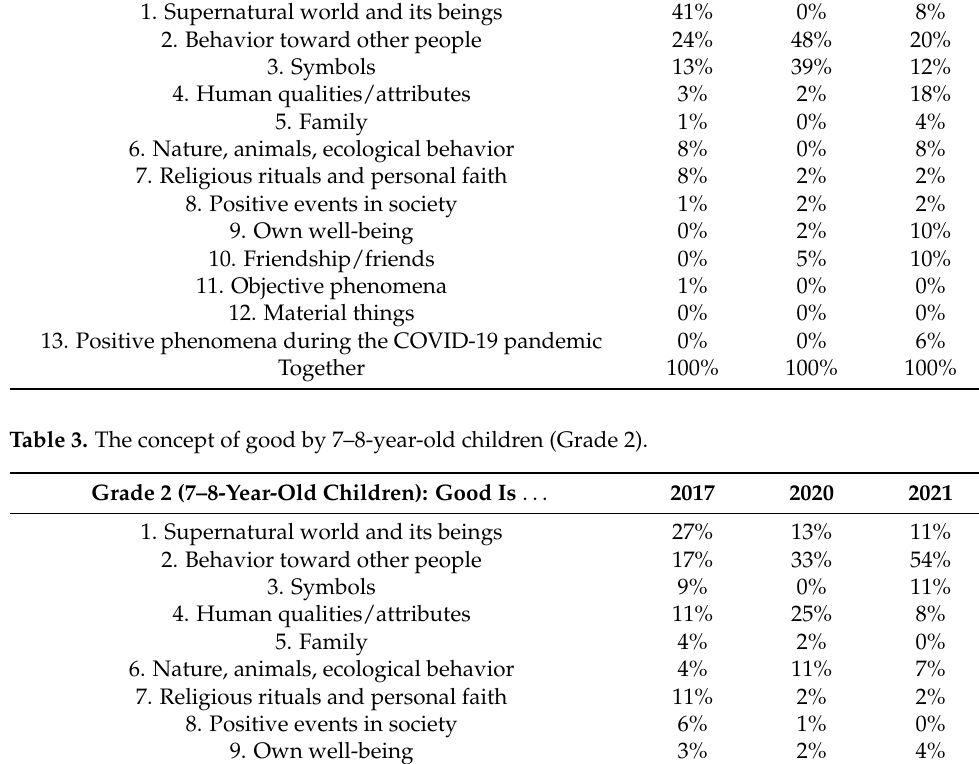
Table 2. The concept of good by 6–7-year-old children (Grade 1). Grade 1 (6–7-Year-Old Children): Good Is . . .